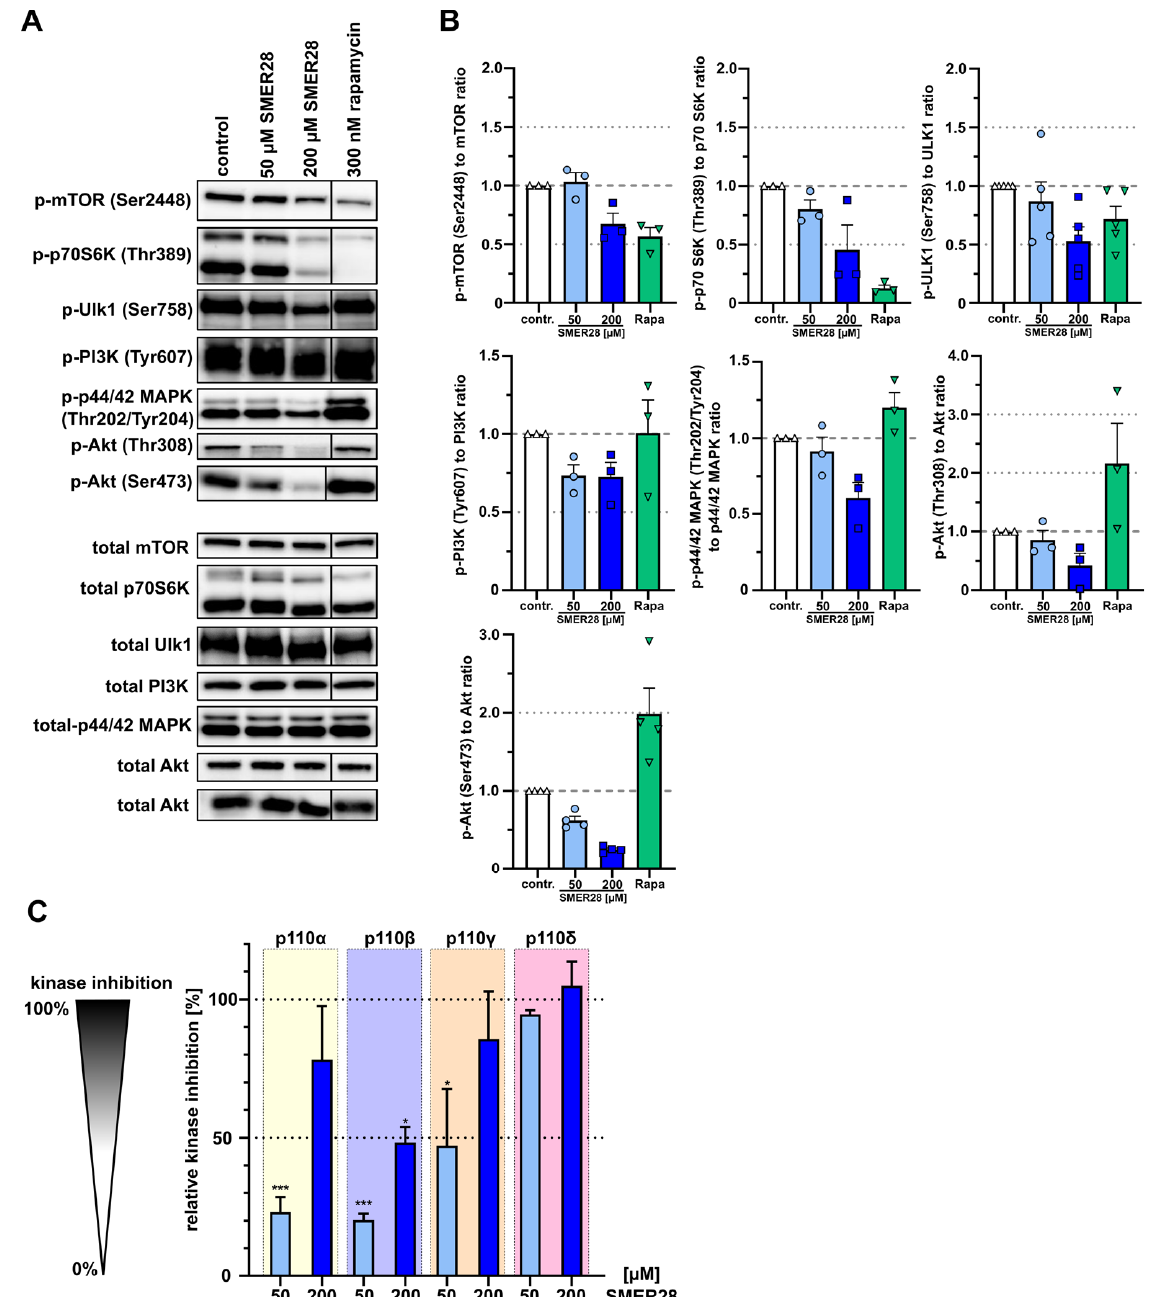
Figure 5. SMER28 inhibits PI3K signaling. ( A ) Western Blot analysis of U-2 OS cells. Cells were incubated in the presence or absence of 50 or 200 µ M of SMER28 or 300 nM rapamycin (Rapa), as indicated, for 4 h, lysed in Laemmli buffer and analyzed for levels of phospho-proteins and their respective total proteins. ( B ) Quantifications of relative ratios of phosphorylated proteins to total proteins as indicated. Data are means ± s.e.m. of protein levels derived from at least three independent experiments. ( C ) Inhibition of activities of class I PI3 kinases containing the regulatory subunits p110 α , - β , - γ and - δ by 50 or 200 µ M SMER28, as measured using an in vitro PI3 kinase activity/inhibitor ELISA. The respective relative kinase inhibition was normalized to the data of the reaction without kinase, equaling 100% inhibition per definition. Data represent mean values ± s.e.m; n = 4. * p < 0.05, *** p < 0.001, compared to the reaction without kinase (not shown, 100%); one way